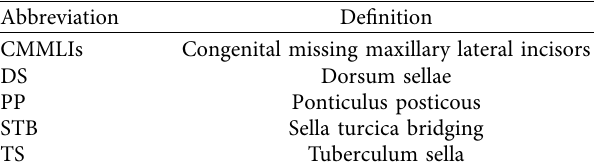
Table 4: List of abbreviations used in the